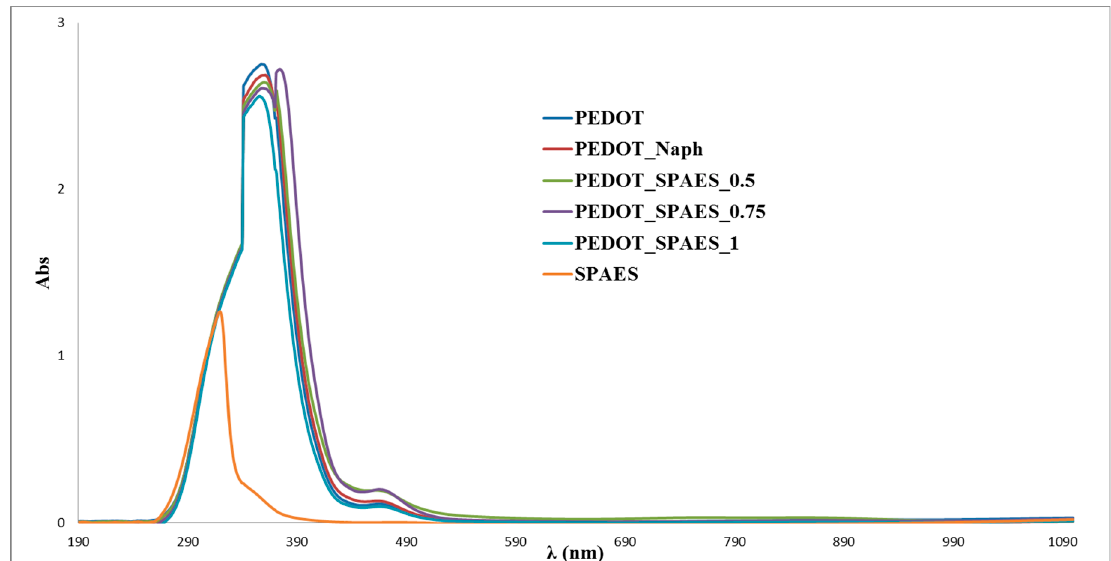
Figure A10. UV absorbance data of PEDOT, PEDOT_Naph, PEDOT_SPAES, and SPAES samples synthesized in NMP.